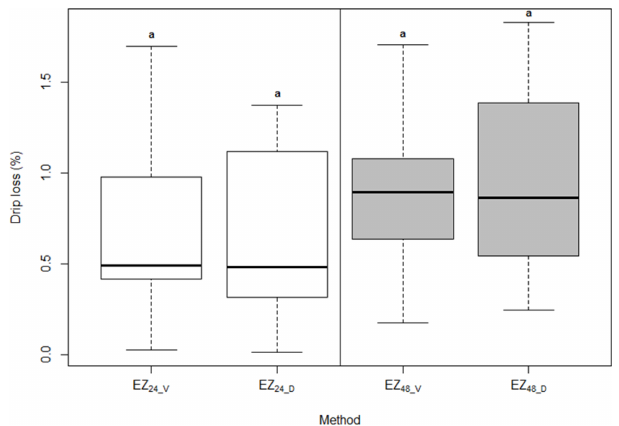
Figure 1. Distributions of the drip loss obtained on ventral and dor- sal cores with EZ method after 24 and 48h. For abbreviations see Table 1. Letters represent the results of paired t test with signifi- cance level p< 0 . 05.